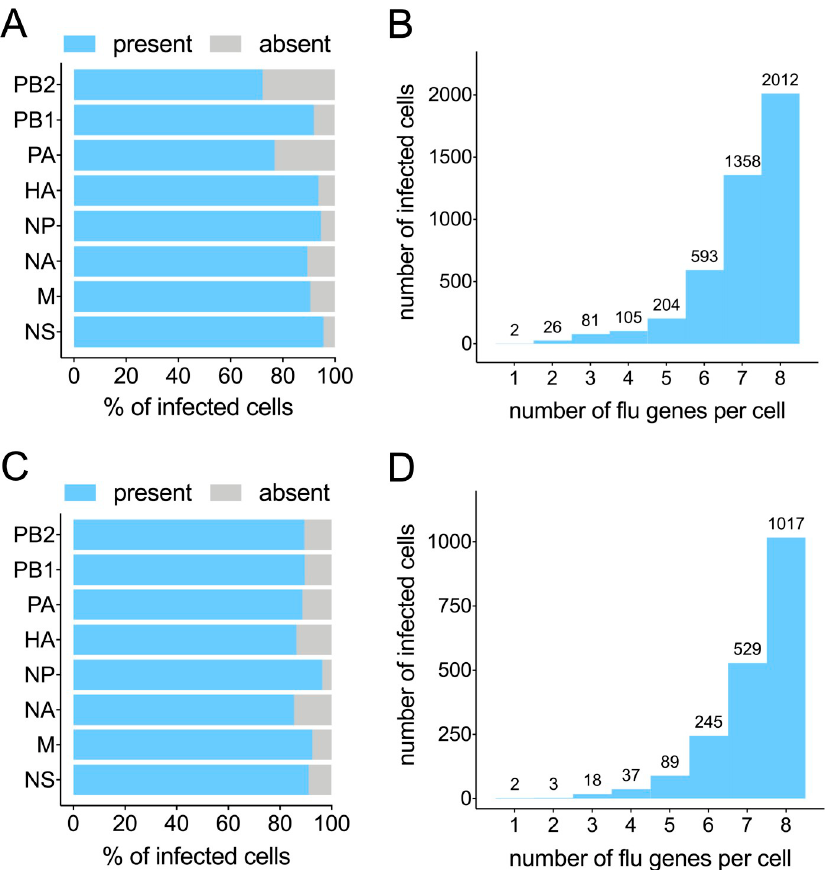
Fig 5. Many infected cells have undetectable levels of one or more viral transcripts. (A) The percentage of all Cal07-infected cells called as positive for the indicated gene segments (B) All Cal07-infected cells binned by the total number of viral gene segments that were called positive, with the actual numbers of cells in each group detailed above. (C) Same figure as (A) for Perth09. (D) Same figure as (B) for